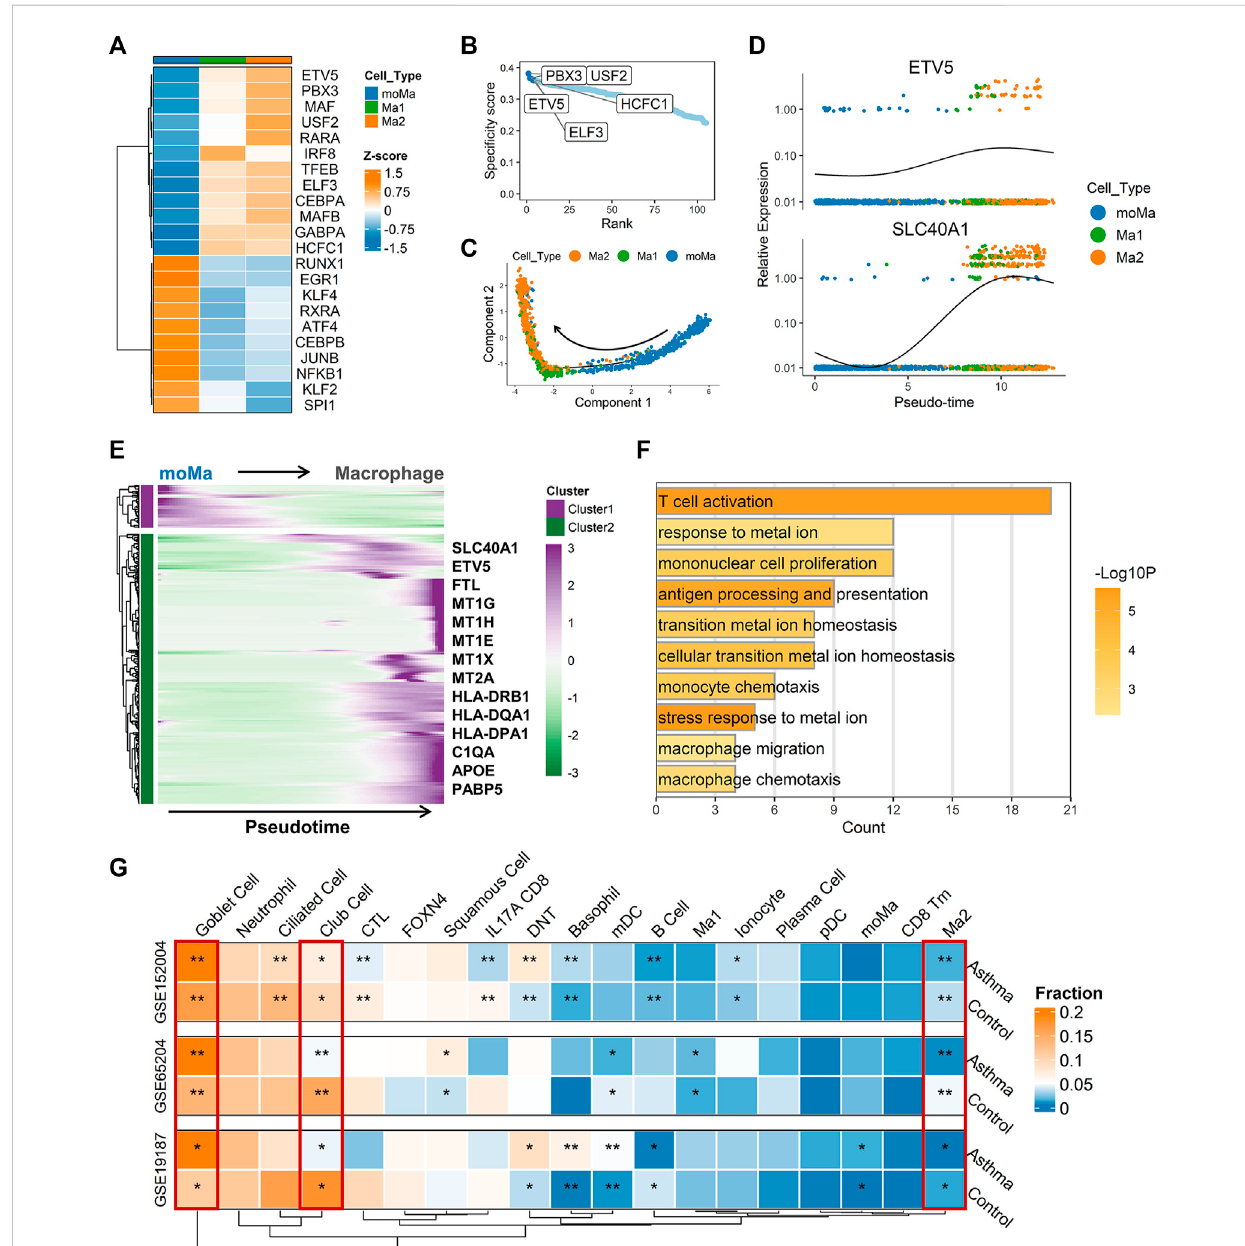
FIGURE 5 Single-cell trajectory and transcriptional regulatory network analysis revealed potential biological role of SLC40A1. (A) Heatmap of transcription factor (TF) activity (rows) in macrophages (subclusters Ma1 and Ma2) and moMa (columns), as identi fi ed by SCENIC. (B) Ranks of TFs in macrophage Ma2subsetbasedonregulonspeci fi cityscores,with fi vemosttranscriptionallyactiveTFsscreened. (C) MonoclepseudotimetrajectoryanalysisofmoMa and macrophages (subclusters Ma1 and Ma2), showing a major trajectory of moMa differentiation into macrophages. Direction of arrow indicates pseudotime direction. (D) Feature plot showing the expression patterns of ETV5 and SLC40A1 along the pseudotime cell trajectory. (E) Gene expression dynamics along pseudotime trajectory. Genes clustered into two gene sets, each characterized by speci fi c expression pro fi les. Genes in cluster 2exhibitedincreasedexpressionalongpseudotime,asdepictedbyaselectionofcharacteristicgenes.Colorbarsfromgreentopurplerepresent Z score. (F) Enriched GO terms for genes in cluster 2. (G) Heatmap of proportion of major cell subtypes within airways of allergic asthmatic patients and healthy controls in each dataset predicted from deconvolution analysis. Statistical signi fi cance was assessed using Wilcoxon rank-sum test. Asterisks indicated p values for childhood allergic asthma versus control. * p < 0.05, ** p < 0.01. GO, gene ontology; moMa, monocyte-derived macrophages; SCENIC, single- cell regulatory network inference and